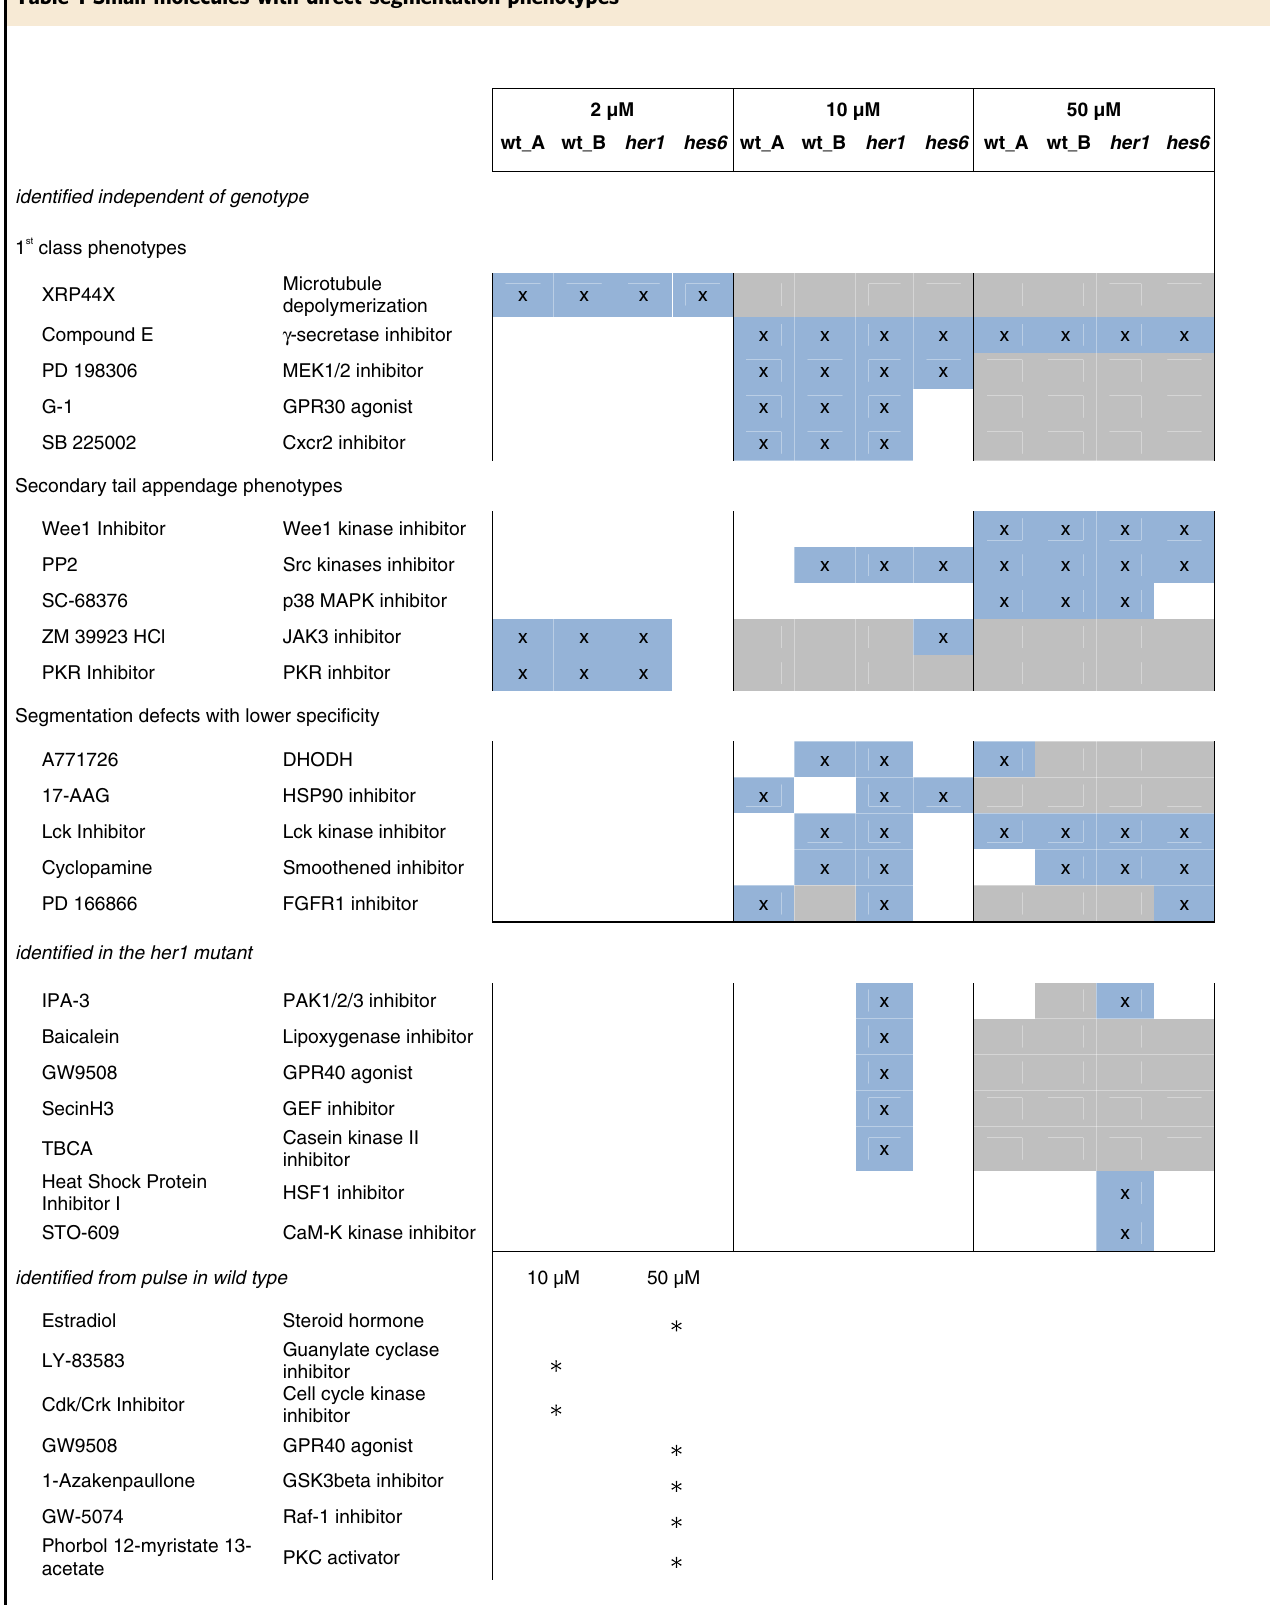
Table 1 Small molecules with direct segmentation